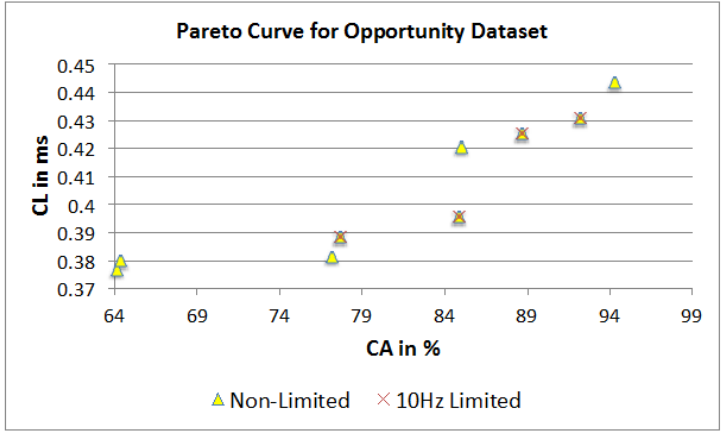
Figure 23. Dominant points on the Pareto